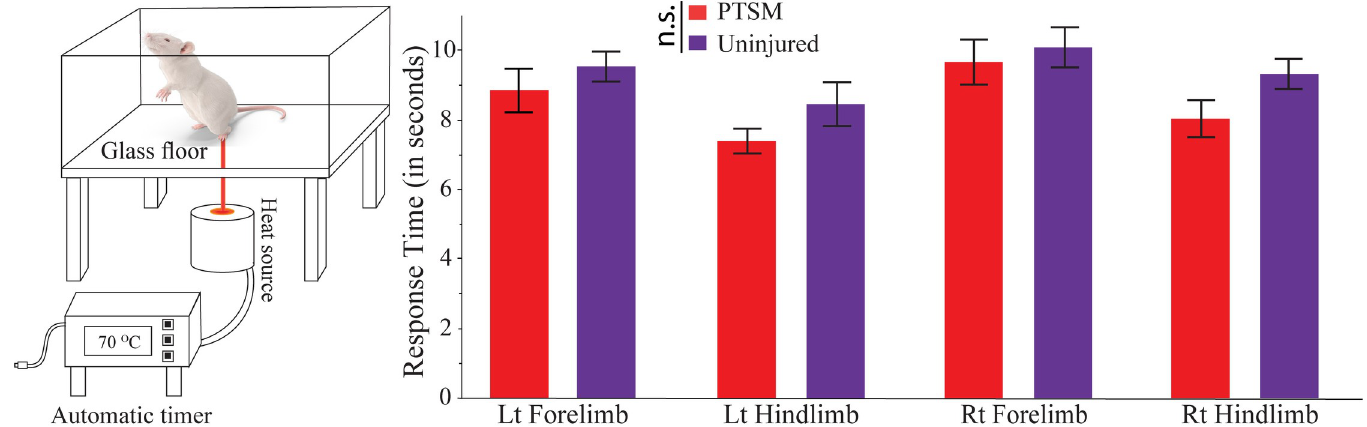
Fig 3. Modified Hargreaves method to test for thermal allodynia. A comparison between uninjured and PTSM rats. The time between animal exposure to thermal stimuli and their animal response was not statistically different between the two groups. The measurements were done in each of the four limbs where the p -value for left forelimb is 0.379, for left hindlimb is 0.146, for right forelimb is 0.626, and for right hindlimb is 0.067. Data are presented as mean ± standard error of mean and statistics were determined pairwise via Student’s t-test.